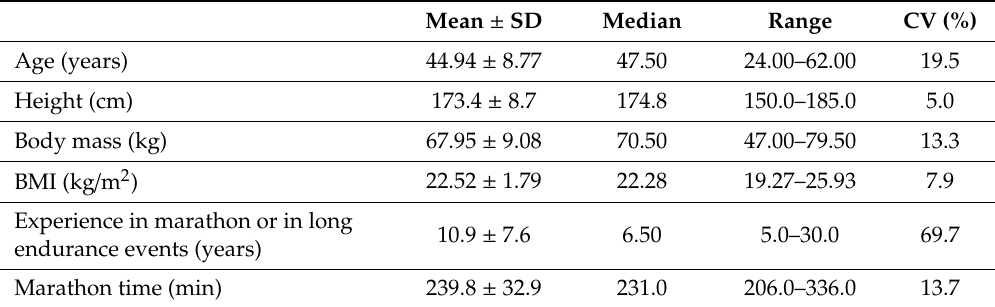
Table 1. Participants’ age, morphological characteristics, and training information ( n =